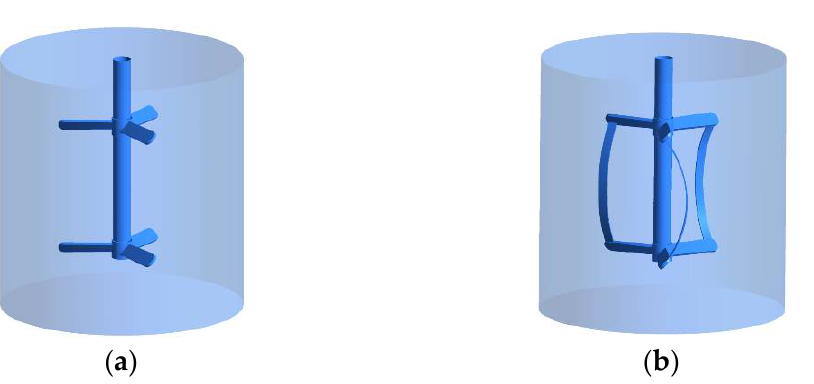
Figure 1. Sketch of the stirred tank.